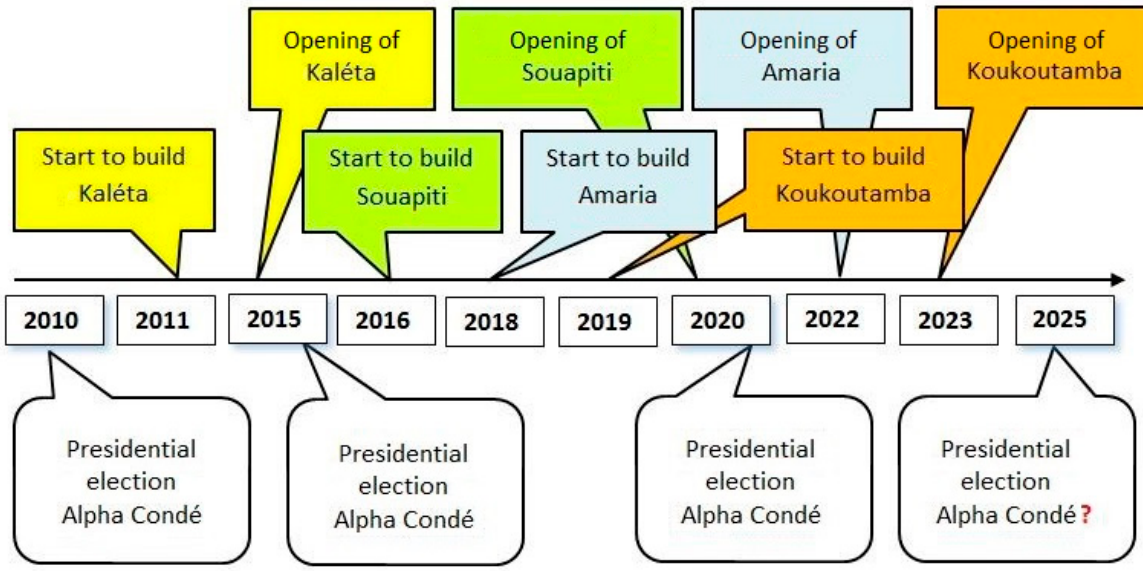
Figure 2. Presidential elections and hydroelectric plant program development. During the last ten years, electricity production increased by 13% and the distribution network was developed, which improved the service of 26 cities and 36 cities in central and coastal Guinea, respectively, including Conakry. In Guinea, the average rate of access to energy services is 18.1%; 47.8% in urban areas and 2% in rural areas, respectively. Energy consumption is concentrated in urban areas while it is almost unavailable in rural households. Breaks in the supply of electricity are still a problem for the people, so very often small enterprises use man power to drive their businesses (e.g., factories producing clothes use sewing machines driven by foot pedals) and very often go to the airport to read and study at the evenings under the lights of the lamps installed in the airport parking area. In Guinea, only 2% of the rural population has access to electricity. Not much has changed in the ten years of Alpha Cond é ’s presidency [76]. However, it should be